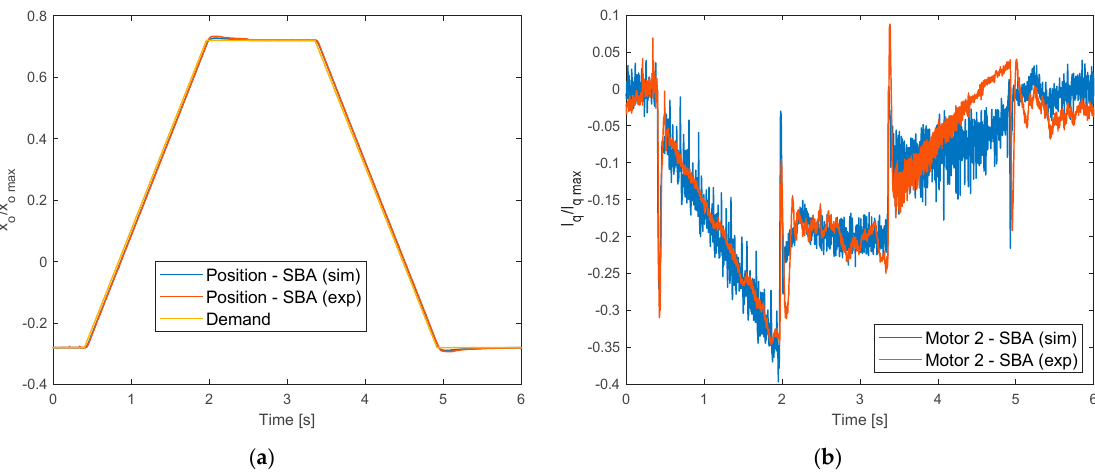
Figure 6. Time-domain model validation: position tracking in SBA mode with 100 kN/m spring-type loading (in Equation (24), k e = 10 5 N/m); ( a ) output position; ( b ) motors quadrature currents ( x o max = 25 × 10 − 3 m ; I q max = 25 A).